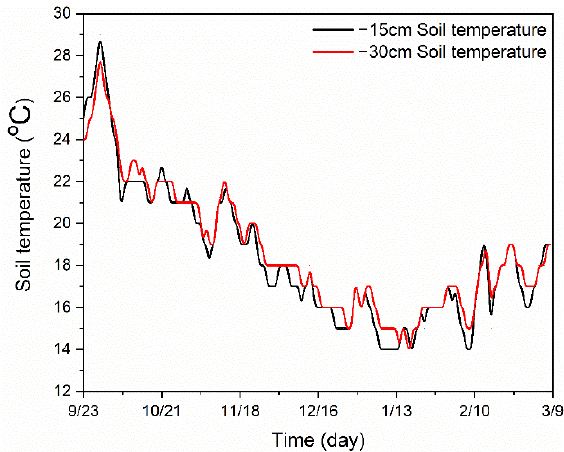
Figure 16. Soil temperature at 15 cm and 30 cm depths at 0:00 during the experimental period.